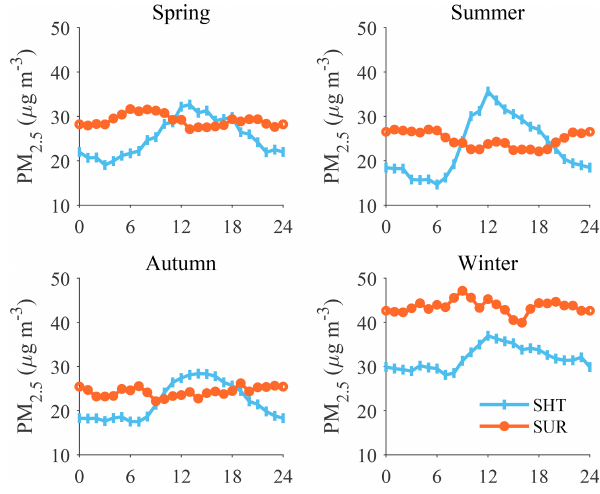
Figure 7. Diurnal variations of PM 2 . 5 mass concentrations (µgm − 3 ) at SHT and SUR in four seasons.